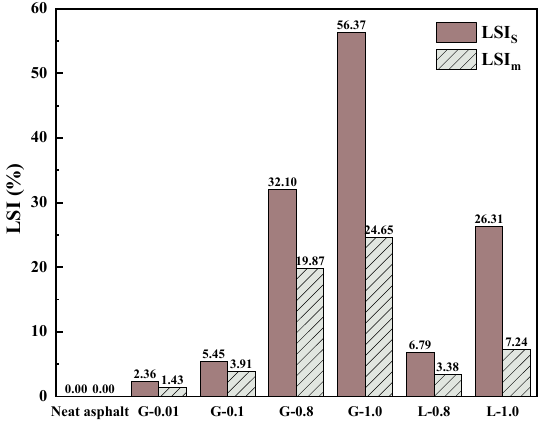
Figure 9. LSI S and LSI m of different samples.